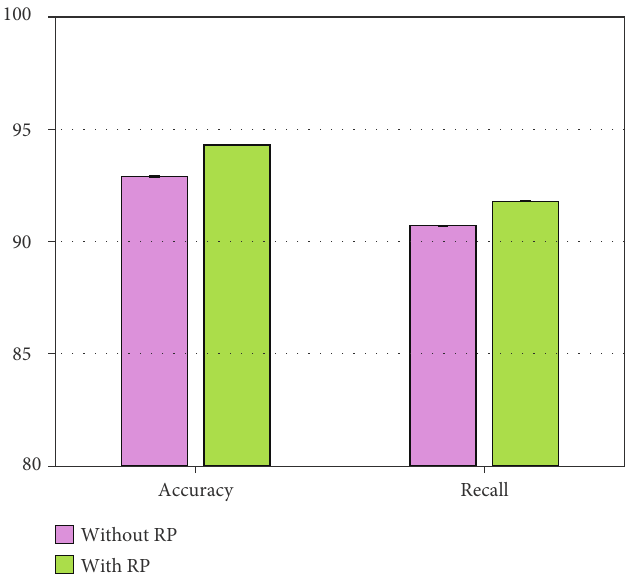
Figure 6: Evaluation on RP Table 2: Evaluation on computer course design. Indicator Before using design After using design